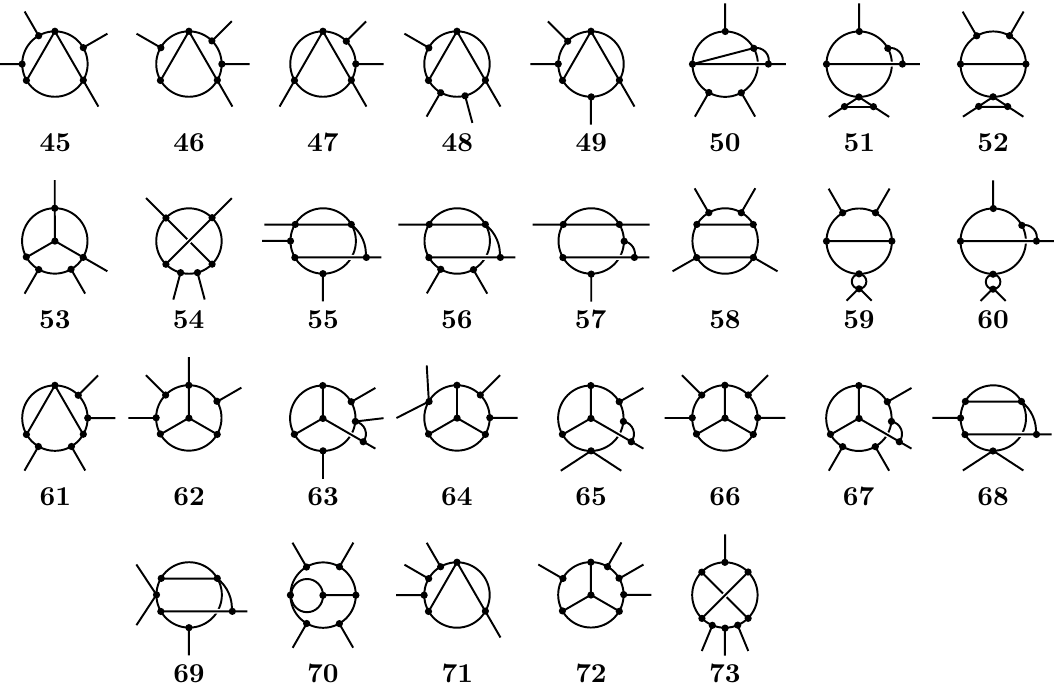
Figure 15 . List of topologies associated to special genuine diagrams ( T i with i = 45 ; (cid:1) (cid:1) (cid:1) ; 73). The topologies are ordered according to speci(cid:12)c (cid:12)eld content needed in order to be considered as genuine. See the text for